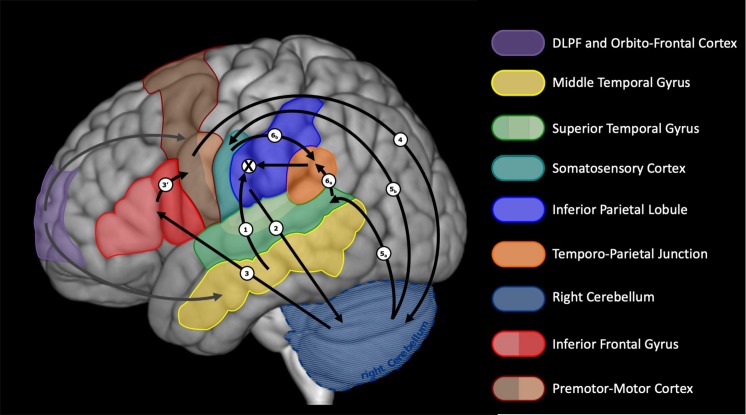
Neuroanatomical network of articulatory planning during expanded inner speech. A tentative description of the sequences of activation is provided, ending up with the comparison between desired and predicted phonetic goals within the inferior parietal lobule. Numbers refer to the assumed sequence of activations. The cross sign refers to the comparison that takes place between the intended phonetic goal and the integrated multisensory prediction.